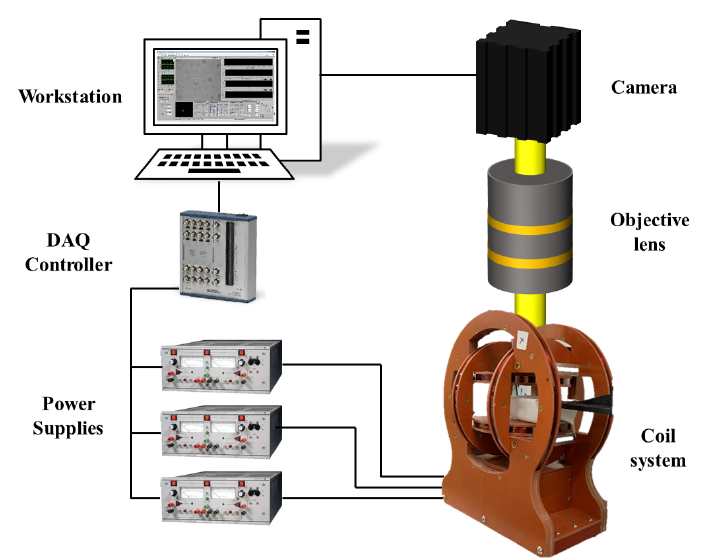
Figure 2. Schematic of the experimental platform generating rotating magnetic fields for microswim- mer